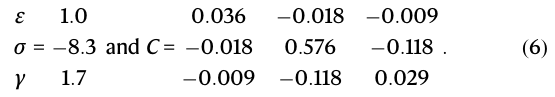
Fig. 6 | Measurements of travel time residuals by cross-correlating stacked waveforms. In each panel, solid lines are linearly stacked waveforms of the exotic pairs of PKIKP multiples. Dashed lines show cross-correlated and shifted original